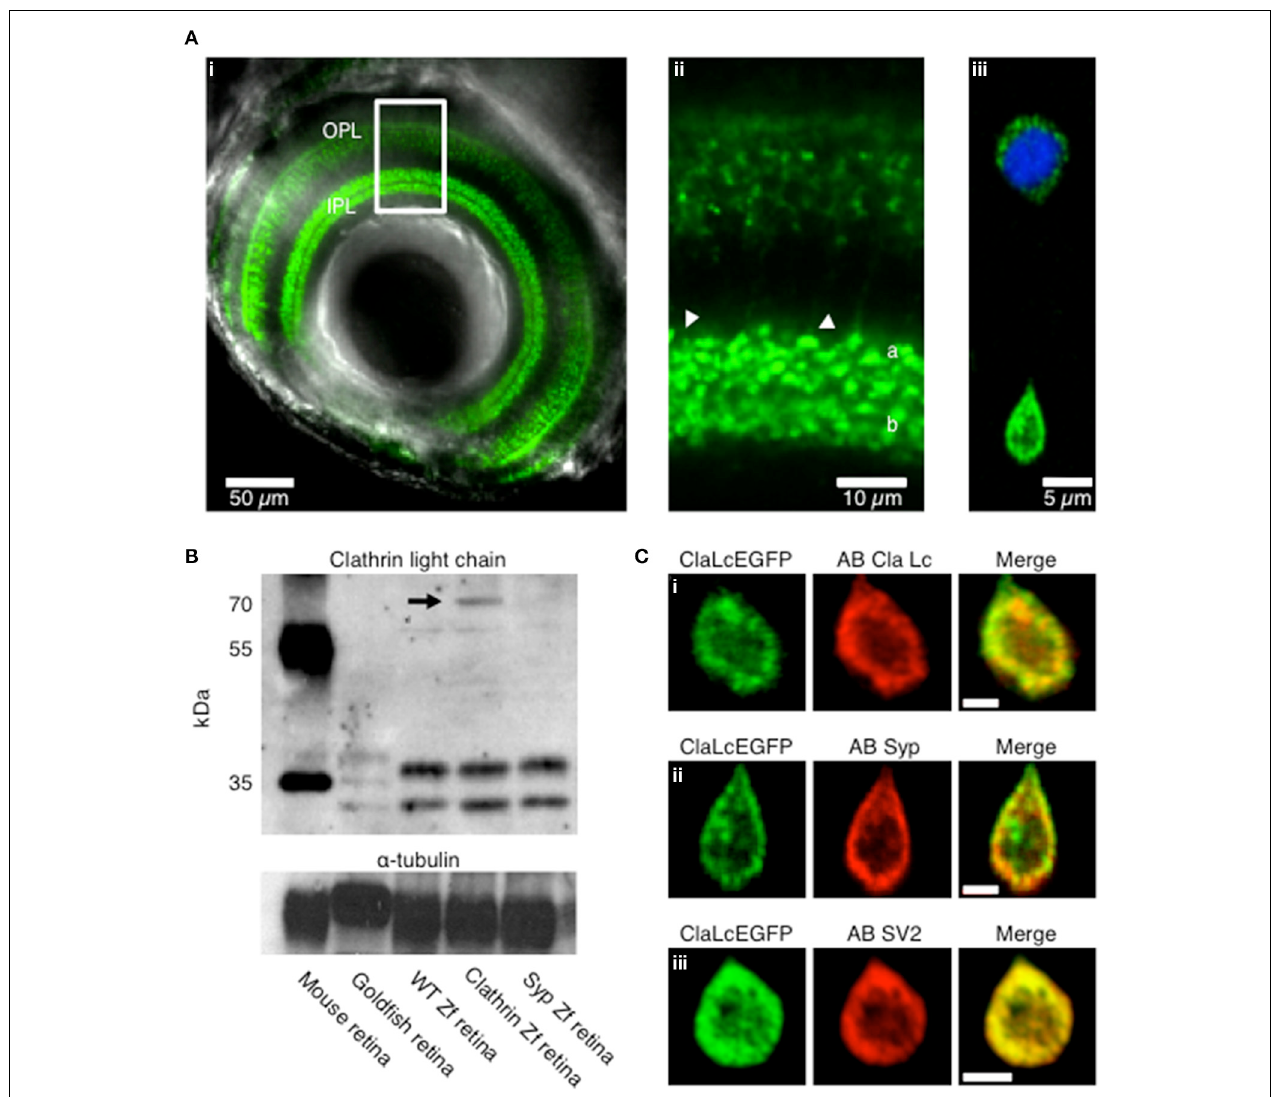
FIGURE 1 | Expression pattern of clathrin in transgenic zebrafish. (A) Confocal image of the eye of a Ribeye:clathrin-EGFP larva ( i , 5dpf). Clathrin LCa-EGFP is expressed densely in the synaptic terminals of bipolar cells in the inner plexiform layer ( ii , IPL). The right-hand panel is an example of a bipolar cell dissociated from such a fish (iii) . (B) Western Blot with a primary antibody directed against clathrin neuronal light chain. Protein bands at appropriate molecular weights were labeled in membrane homogenates of retinae from mouse, goldfish, wild-type zebrafish, Ribeye::ClathrinLCa-EGFP (RCE) zebrafish and Ribeye::synaptophysin-EGFP (RSE) zebrafish. The